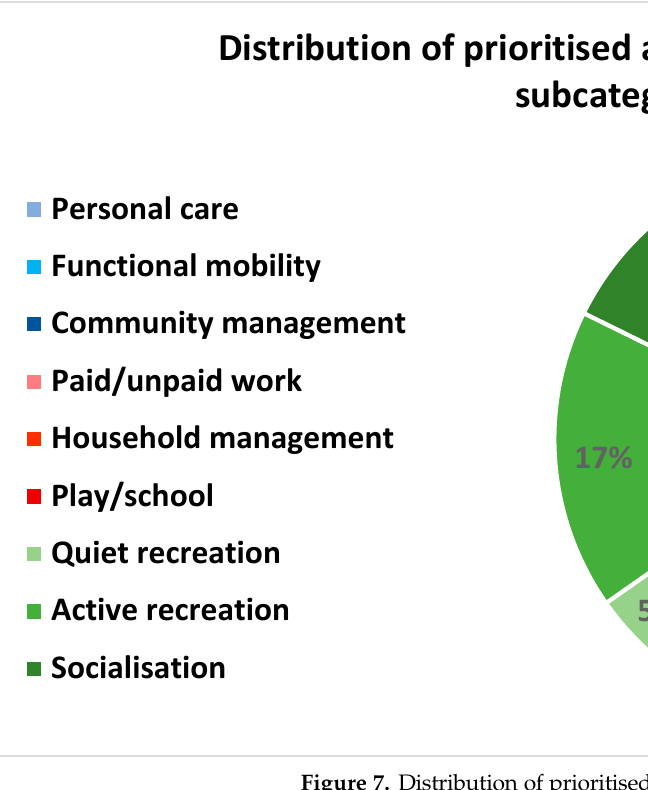
Figure 7. Distribution of prioritised activity problems (%) within the COPM subcategories: self-care (blue) comprising personal care, functional mobility and community management; productive activities (red) comprising paid/unpaid work, household management and play/school; leisure activities (green) comprising quiet recreation, active recreation and socialisation. Patients were the opportunity to prioritise up to five activity problems (see Section 2). COPM data is based on 415 patients.